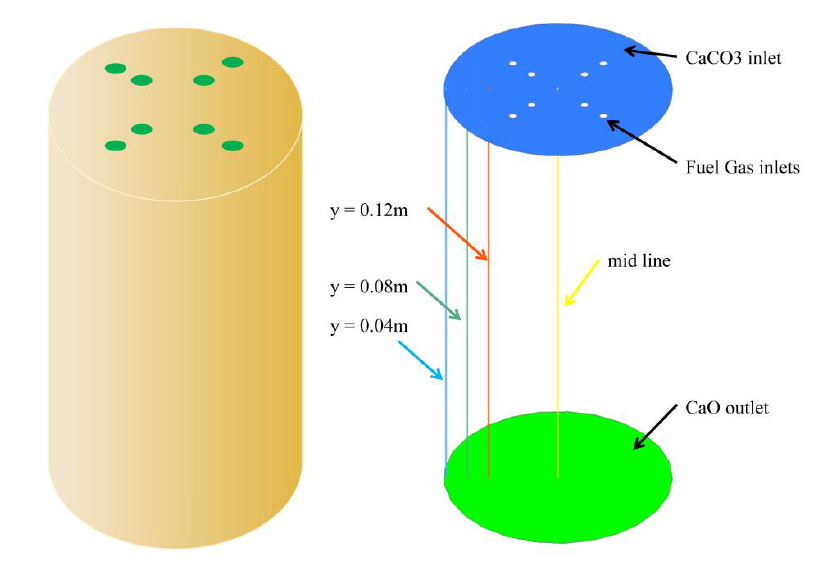
Figure 3. Schematic diagram of calculation area and analysis locations.